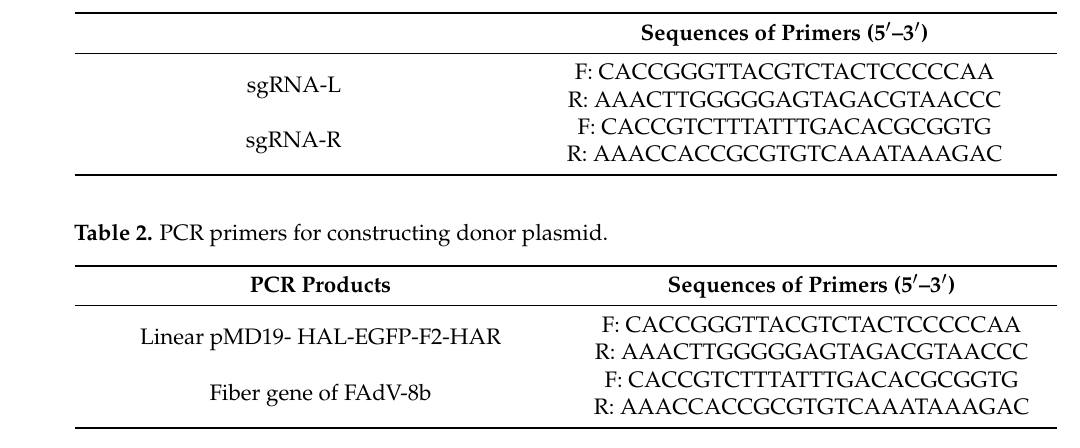
Table 1. List of primers used for sgRNA cloning.